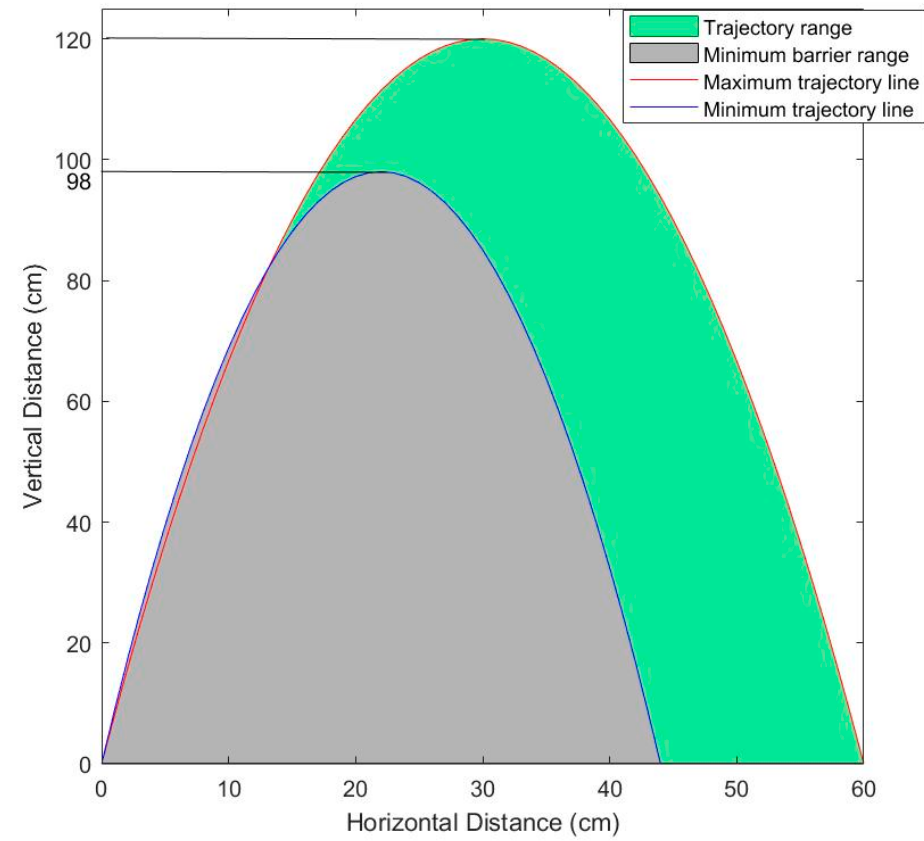
Figure 7. Summary of the experimental results of the robot’s jumping trajectory.